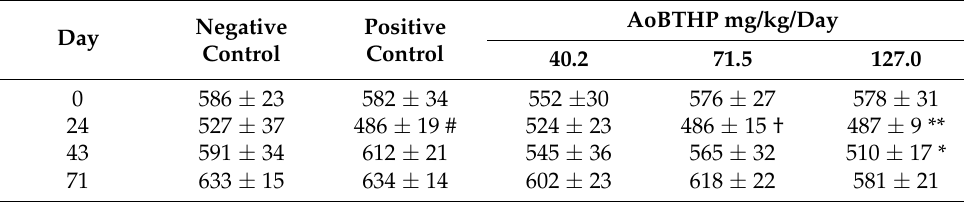
Table 3. Non-fasting glycemia values of animals (mean ± SEM). Day